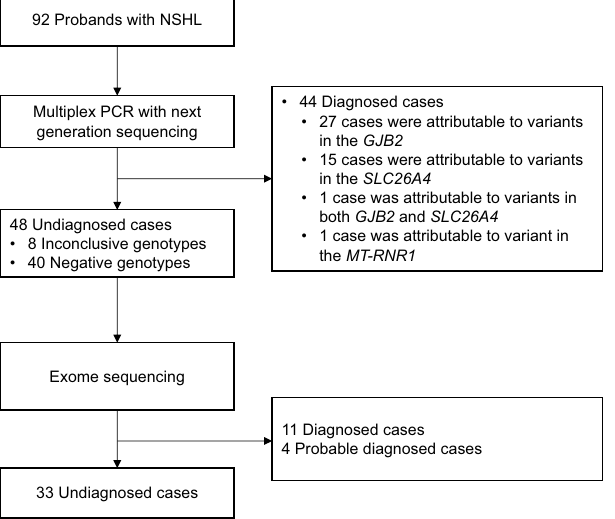
Figure 1. Outline of the study design. Ninety-two patients with non-syndromic hearing loss were enrolled. After carrying out multiplex PCR and next generation sequencing on all the patients, the 48 undiagnosed and 10 patients diagnosed for GJB2 c.109G>A were referred for exome sequencing. NSHL non-syndromic hearing